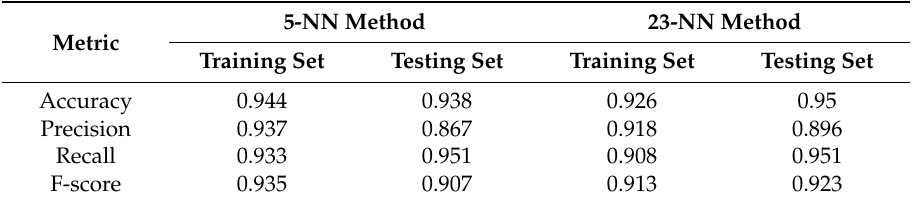
Table 8. Performance of k -NN classifier on training and testing